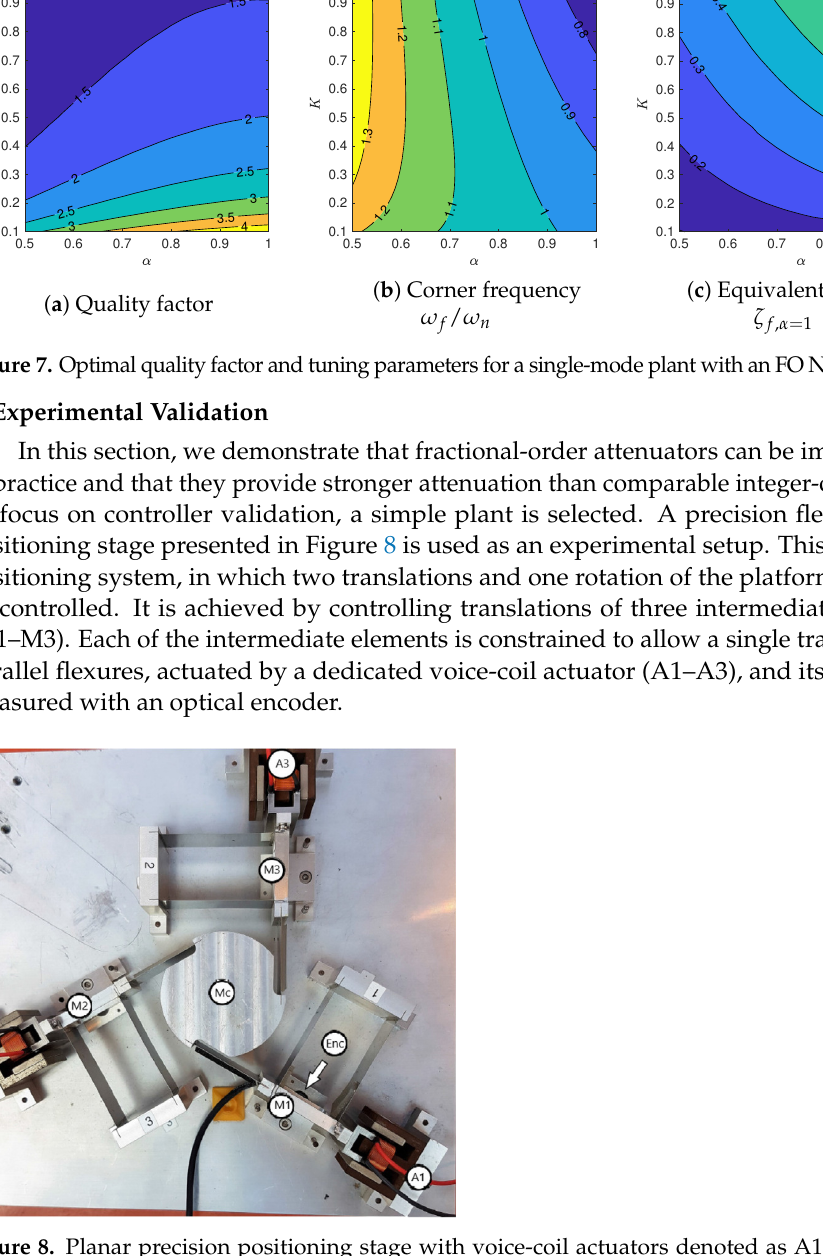
Figure 8. Planar precision positioning stage with voice-coil actuators denoted as A1, A2 and A3 controlling the three masses (indicated as M1, M2 and M3) and constrained by leaf flexures. The central mass (indicated by Mc) is connected to these 3 masses through leaf flexures and linear encoders (indicated by Enc) placed under masses M1, M2 and M3 to provide position